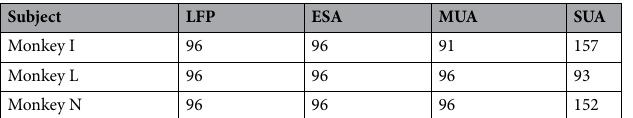
Table 1. Number of channels or units of neural signal types across subjects. For monkey I, the average number of units for MUA (SUA) over 26 recording sessions is 87.08 ± 4.44 (125.73 ±